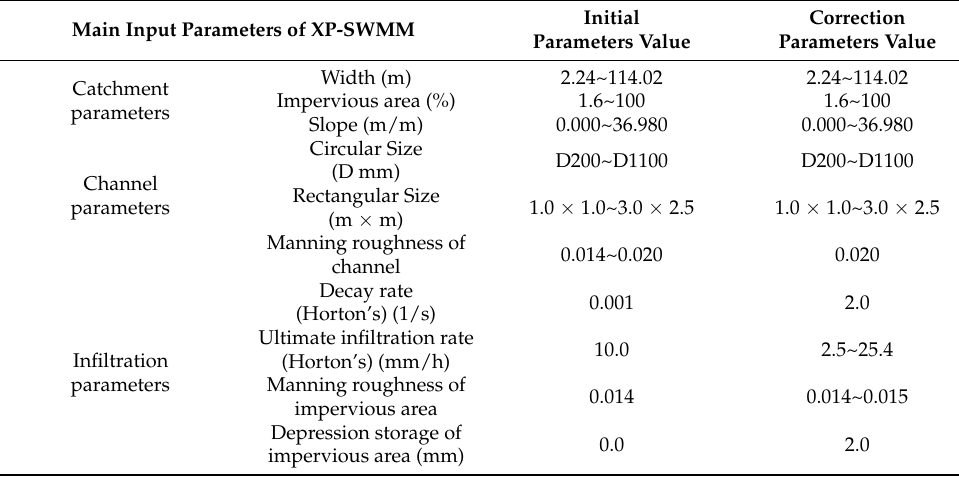
Table 2. Correction results of the main parameters (Dorim 1 watershed).